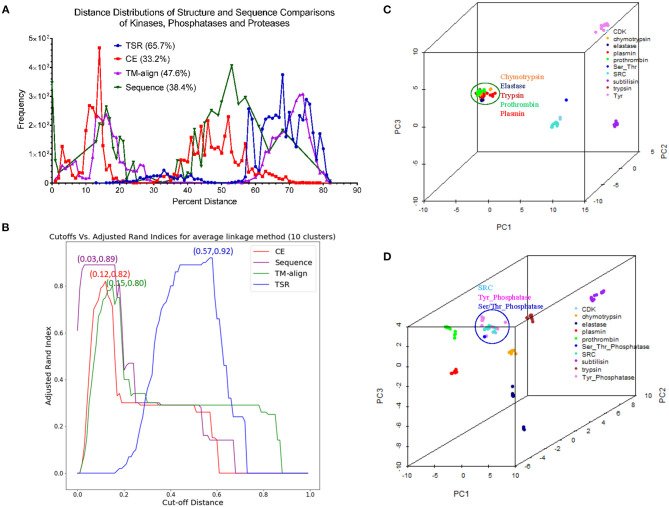
The studies of structure and sequence dissimilarity of proteases, kinases and phosphatases demonstrate differences between methods of structure and sequence comparisons. (A) The distance distributions of the different methods of structure and sequence comparison. Our method uses percentage to show the differences in structures while CE, TM-align use RMSD to show the structural differences. The sequence alignment uses genetic distance. The distance values were normalized to the percentage of distance. The weighted percent distances are indicated. The distance values of pairwise comparison using our method are provided in Supplementary File 14; (B) The plot shows relation between the cutoffs and ARI of different methods for the average linkage clustering method. The number of the clusters was set to ten. The cut-off distances were normalized to 1.0. The cutoff values for the best ARI are indicated; (C) The diagram shows the separation of the clusters using the first three principle components from the RMSD matrix generated by CE method. The protein structures clustered together are circled and labeled; (D) The diagram shows the separation of the clusters using the first three principle components from the distance matrix generated by our method. The protein structures clustered together are circled and labeled.